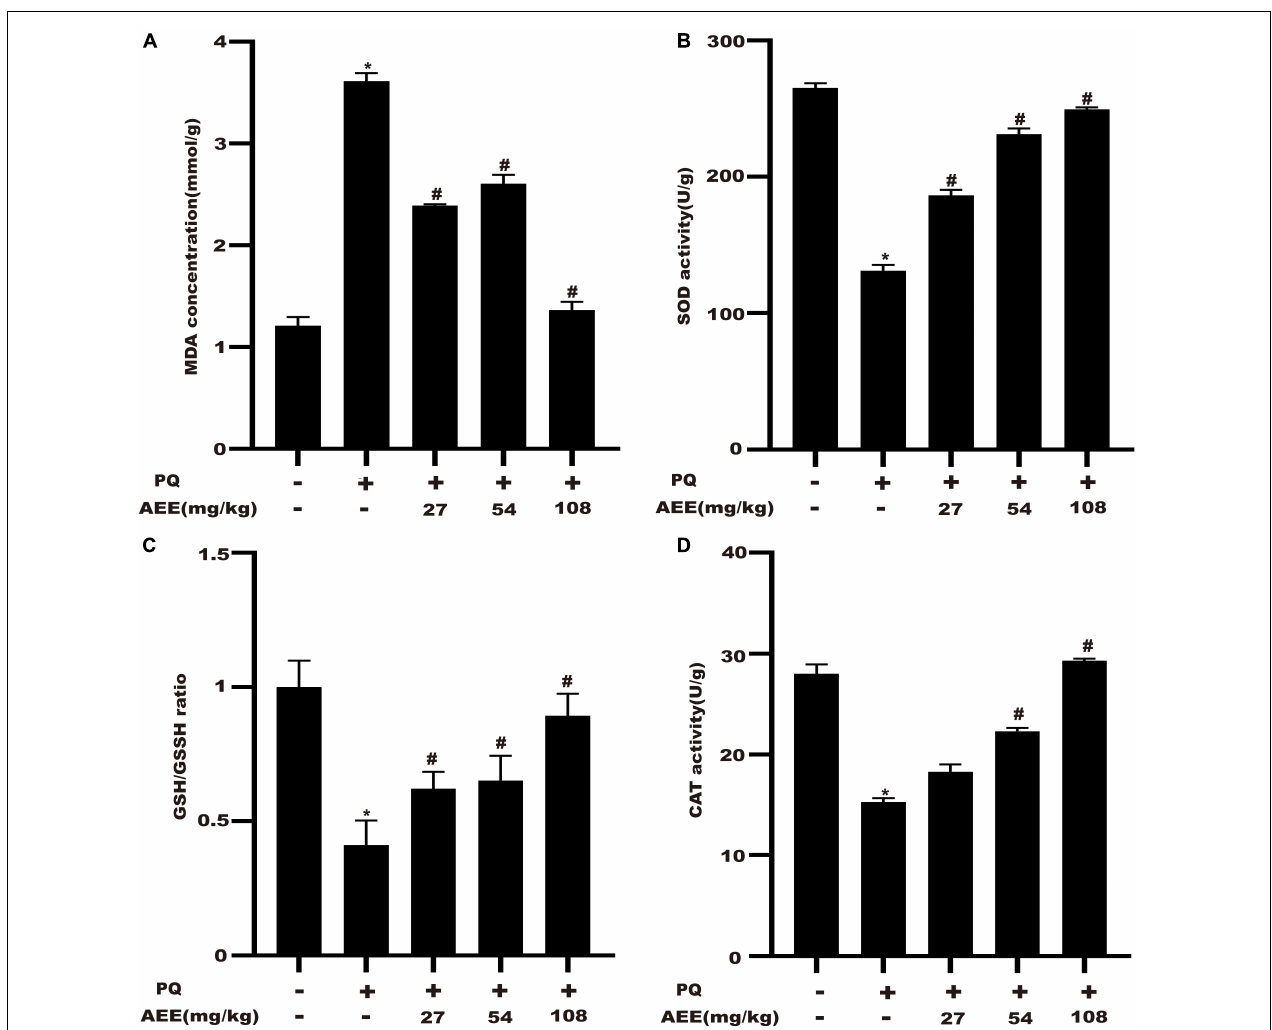
FIGURE 6 | AEE attenuates PQ-induced hepatic oxidative stress in rats. (A) The level of MDA in rat liver was measured in different treatment groups. (B) The activity of SOD in rat liver was determined in different treatment groups. (C) The proportion of GSH/GSSH in rat liver was determined in different treatment groups. (D) The activity of CAT in rat liver was determined in different treatment groups. Values are presented as the means ± SD where applicable ( n = 6). * p < 0.05 compared with the control group; # p < 0.05 compared with the PQ